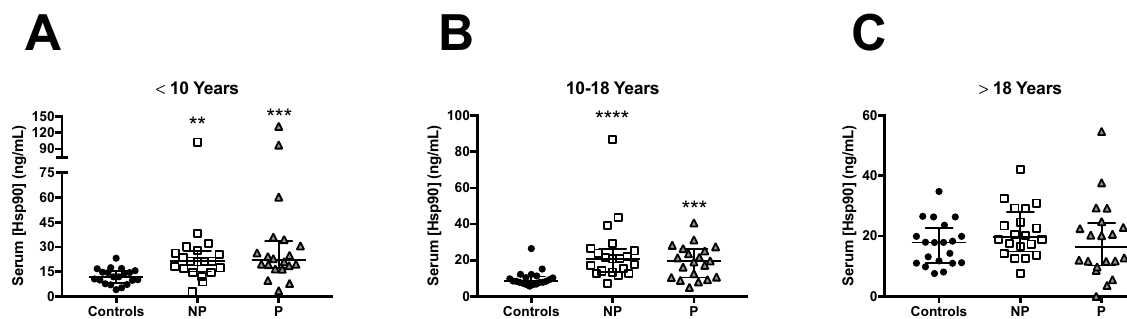
ability of Hsp90 to distinguish youth with autoimmunity from a healthy control population.